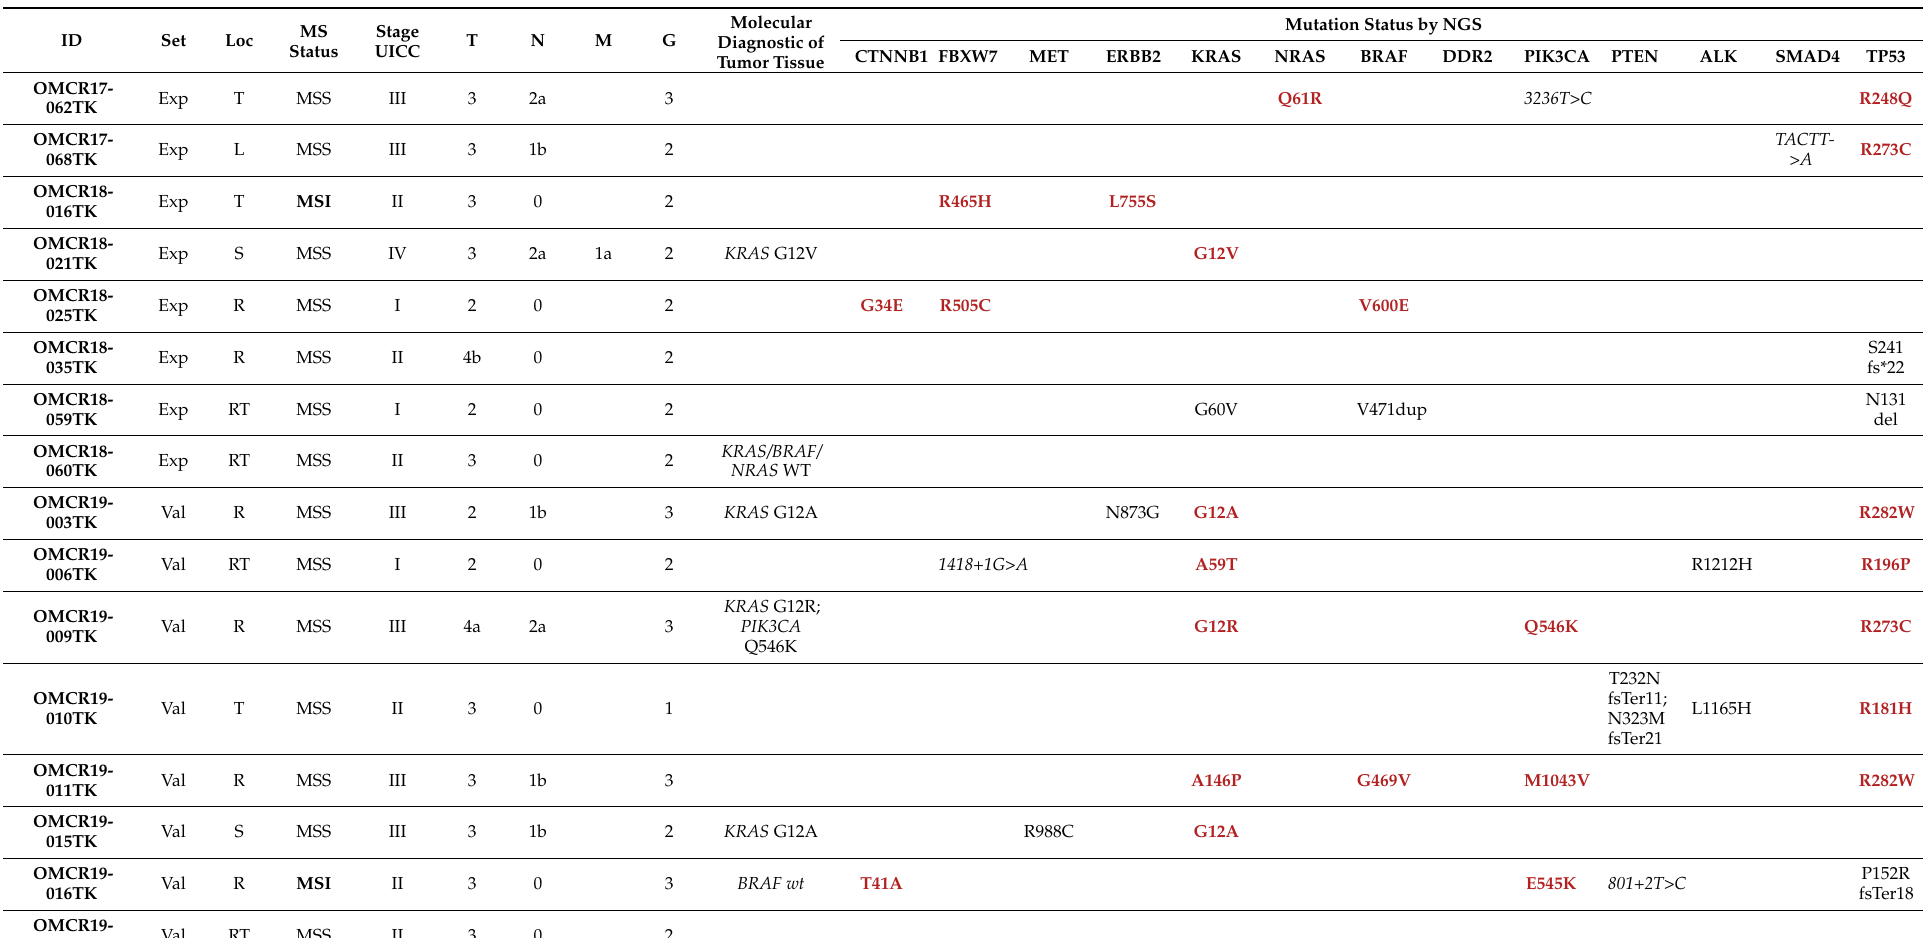
Table 1. Mutations and splice variants in organoids, detected by NGS, and basic pathology data of originating tumors. Oncogenic and truncating mutations of oncosuppressor genes with known activity are reported in red